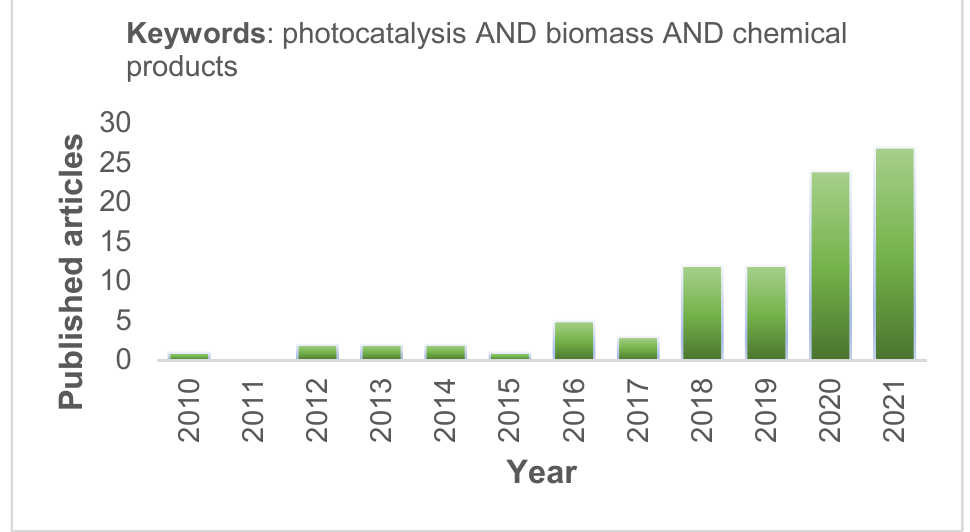
Figure 1. Published articles in the last decade focused on photocatalysis, biomass, and chemical products reported in the Web of Science database.